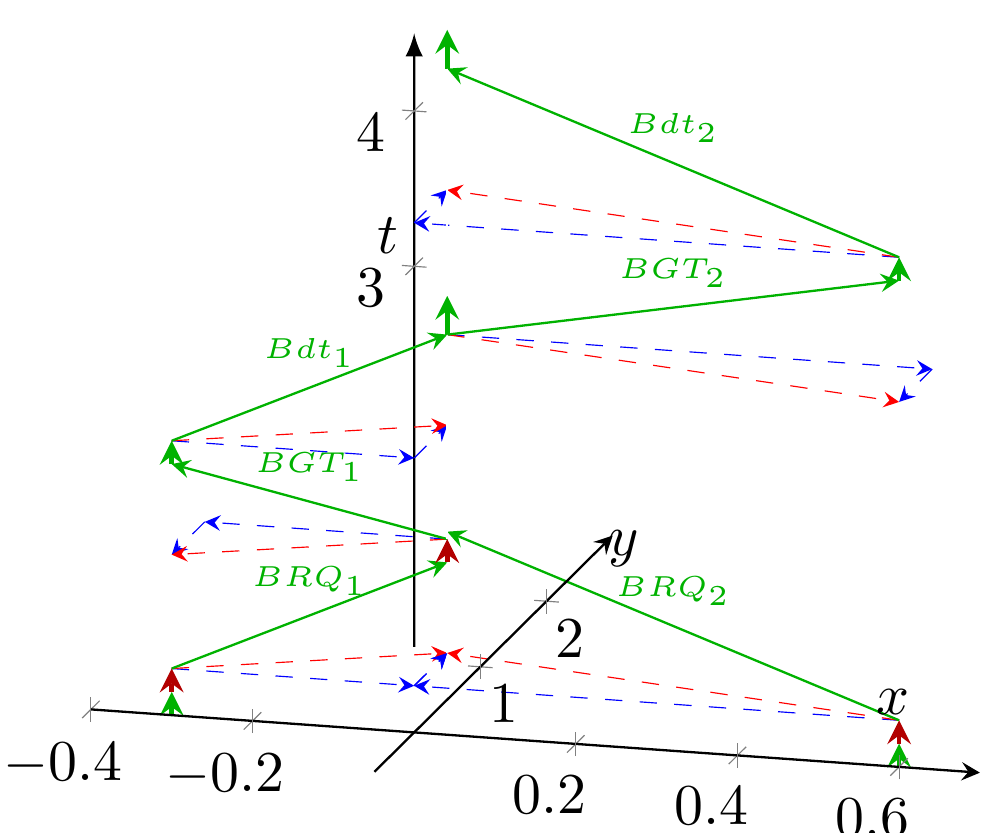
Figure 6. The temporal operating diagram of a technological high-speed single bus: the bus delivers data only in the fractions denoted by vertical green